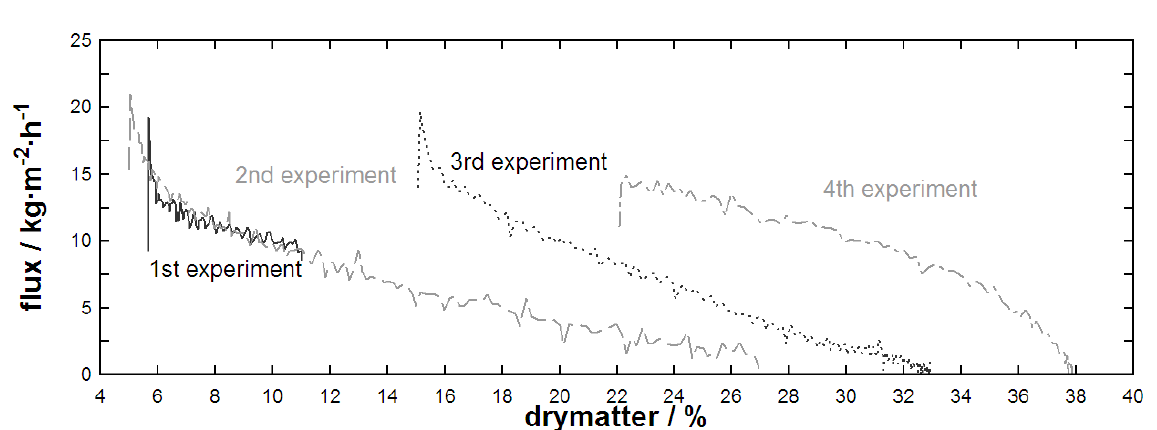
Figure 6. Flux during DCMD of a whey powder solution at different initial